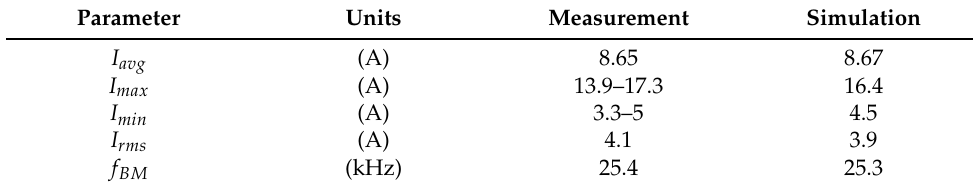
Figure 5. Comparison between simulation results and experimental measurements: discharge current profile ( left ) and current signal power spectral density ( right ). Table 2. Detailed comparison of the discharge current control